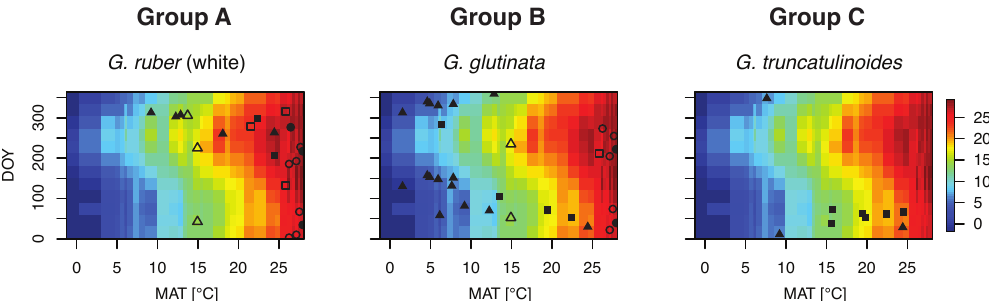
Figure 7. As Fig. 5, but peak timing patterns plotted over contour plots of annual temperature cycle. See Fig. S8 for other species. Symbols denote ocean basins: squares represent the Atlantic Ocean, circles the Indian Ocean and triangles the Pacific Ocean. Open symbols indicate sites affected by